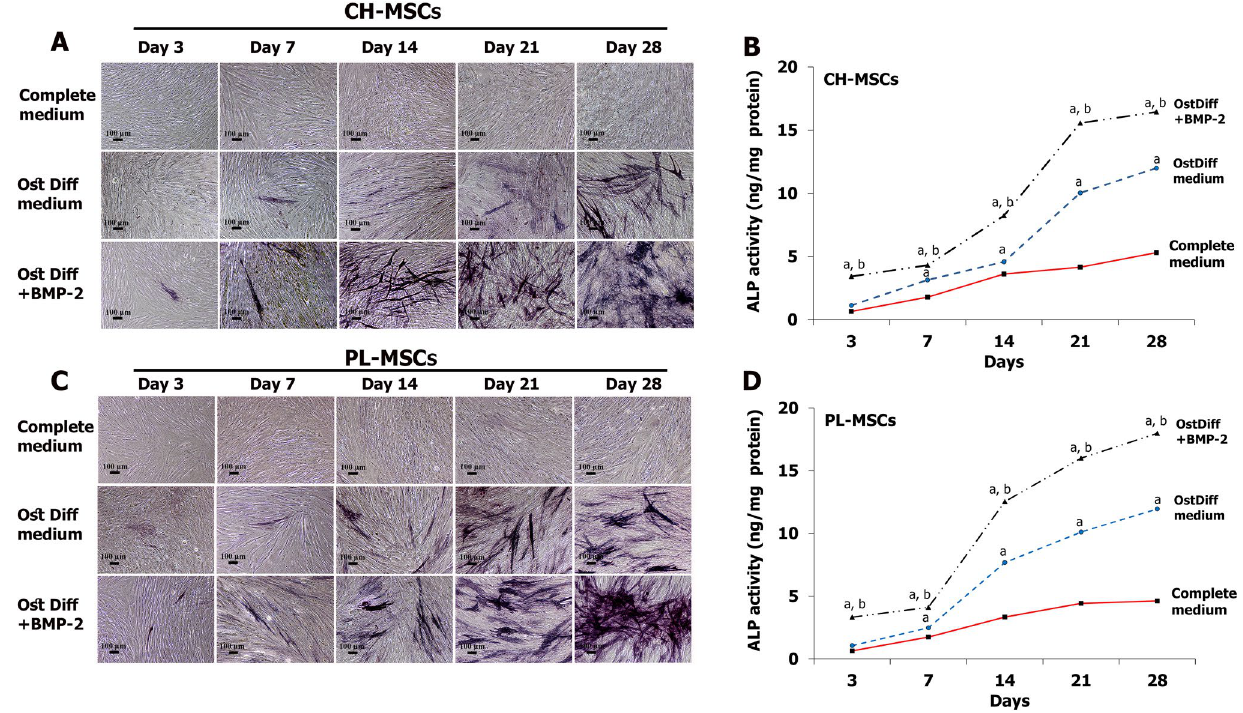
Figure 2. Alkaline phosphatase (ALP) cytochemical staining of CH-MSCs and PL-MSCs cultured in osteogenic differentiation medium with or without BMP-2. ( A , C ) ALP cytochemical staining at different time points shows an increase in ALP activity (deep blue) during osteogenesis. ( B , D ) ALP enzyme activity assay shows a configuration similar to the ALP staining assay. Data calculated from three independent experiments are presented as mean± SEM. p <0.05 compared to MSCs cultured in complete DMEM medium marked as “a”. p <0.05 compared with MSCs cultured in osteogenic differentiation medium (OstDiff medium) marked as “b”. Scale bar = 100